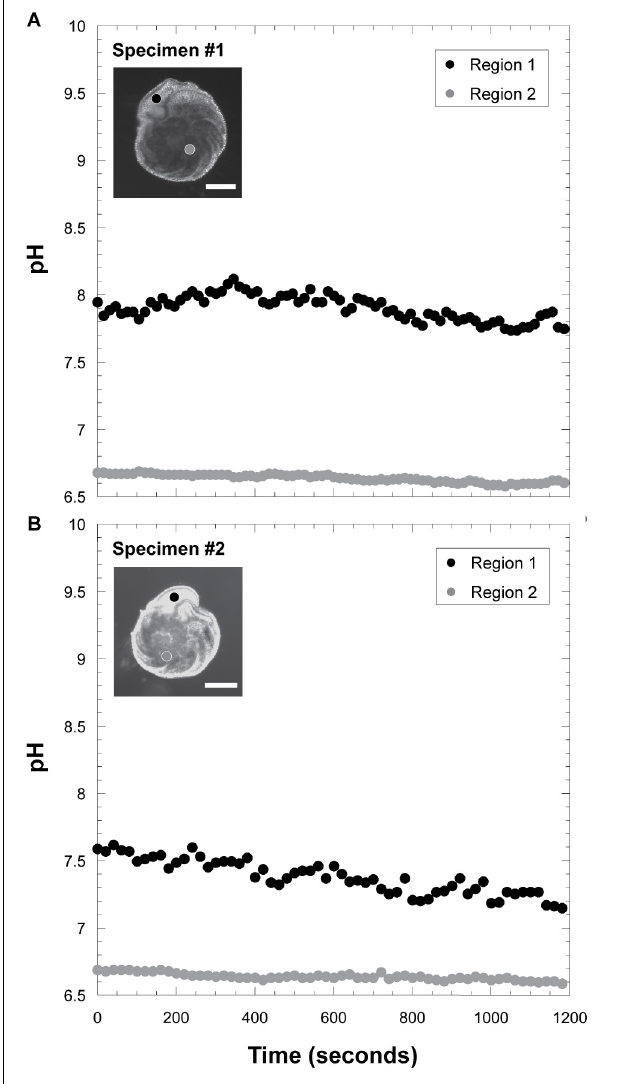
FIGURE 8 | Measurements of intracellular pH. (A) Intracellular pH fluctuation in specimen #1. Scale bar = 100 µ m. (B) those in specimen #2. Scale bar = 100 µ m. The black circle indicates pH signals in the ultimate chamber (Region 1), and the gray circle indicates pH in the inner chamber (Region